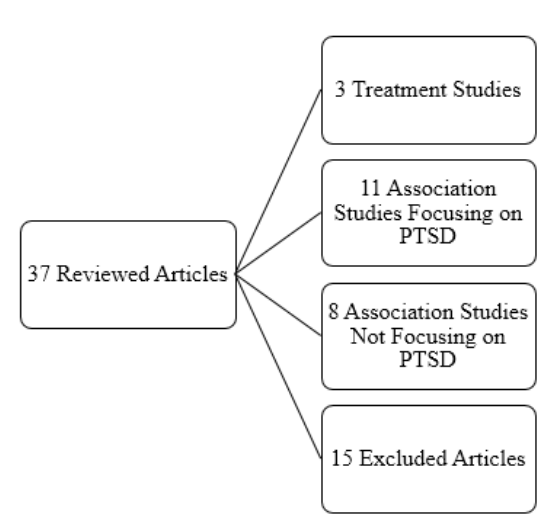
Figure 2. Results of Search.